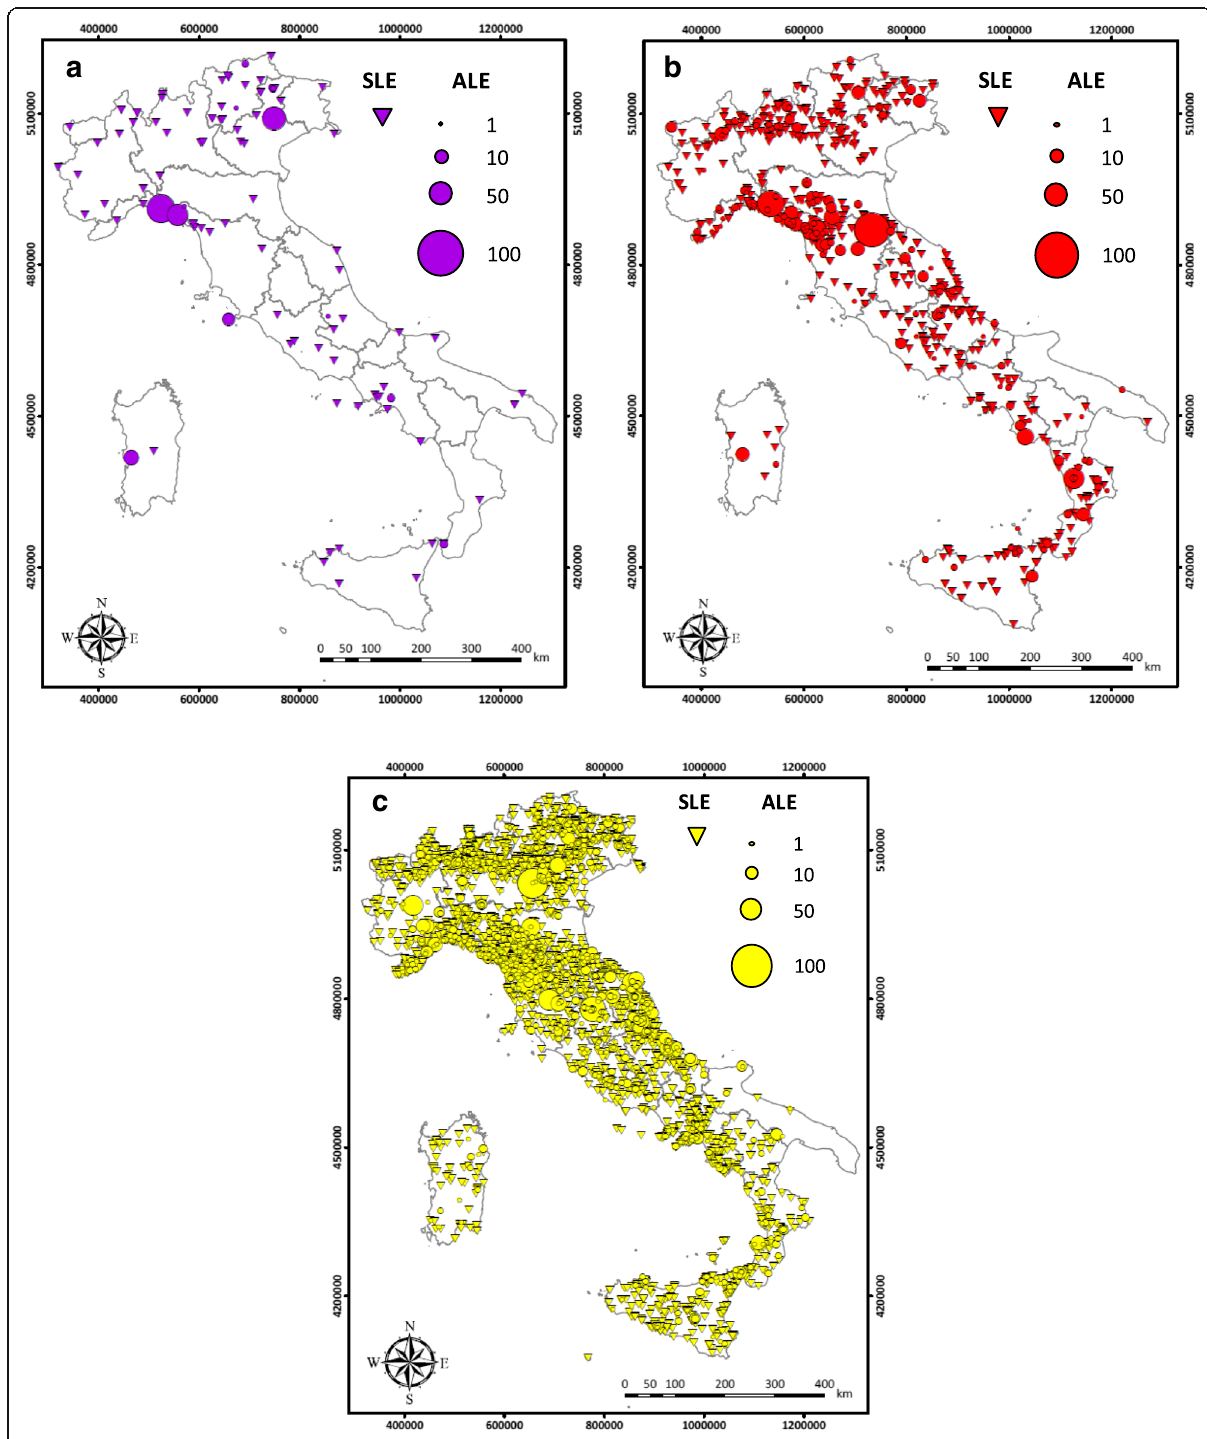
Fig. 6 Single (SLE) and areal (ALE) landslide events associated with: ( a ) victims and/or missing persons (i.e. C1, very severe consequences); ( b ) injured persons and/or evacuations (i.e. C2, severe consequences); ( c ) no physical harm to people (i.e. C3, minor